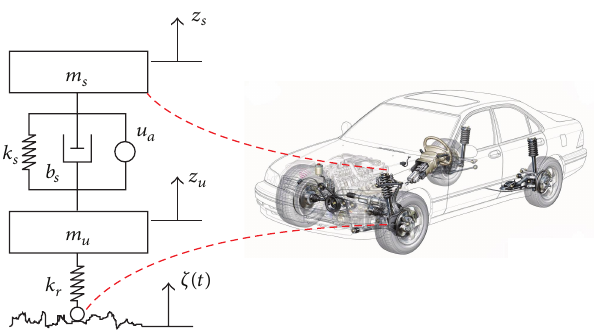
Figure 1: Active suspension system for a quarter